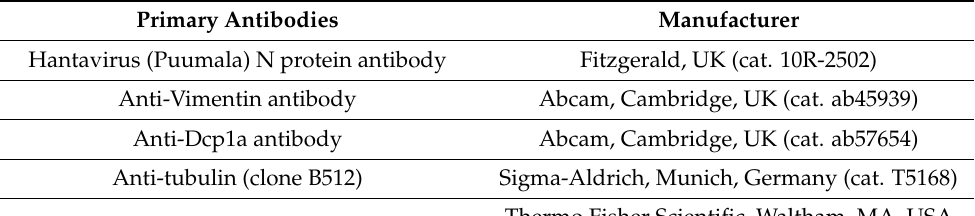
Table 1. Reagents for fluorescence and immunofluorescence staining. Primary